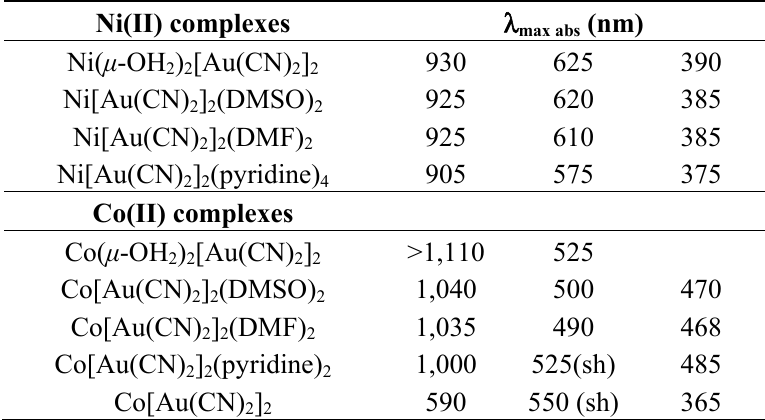
Table 6. Absorbance maxima ( λ absorbance spectra of the M[Au(CN) prepared from